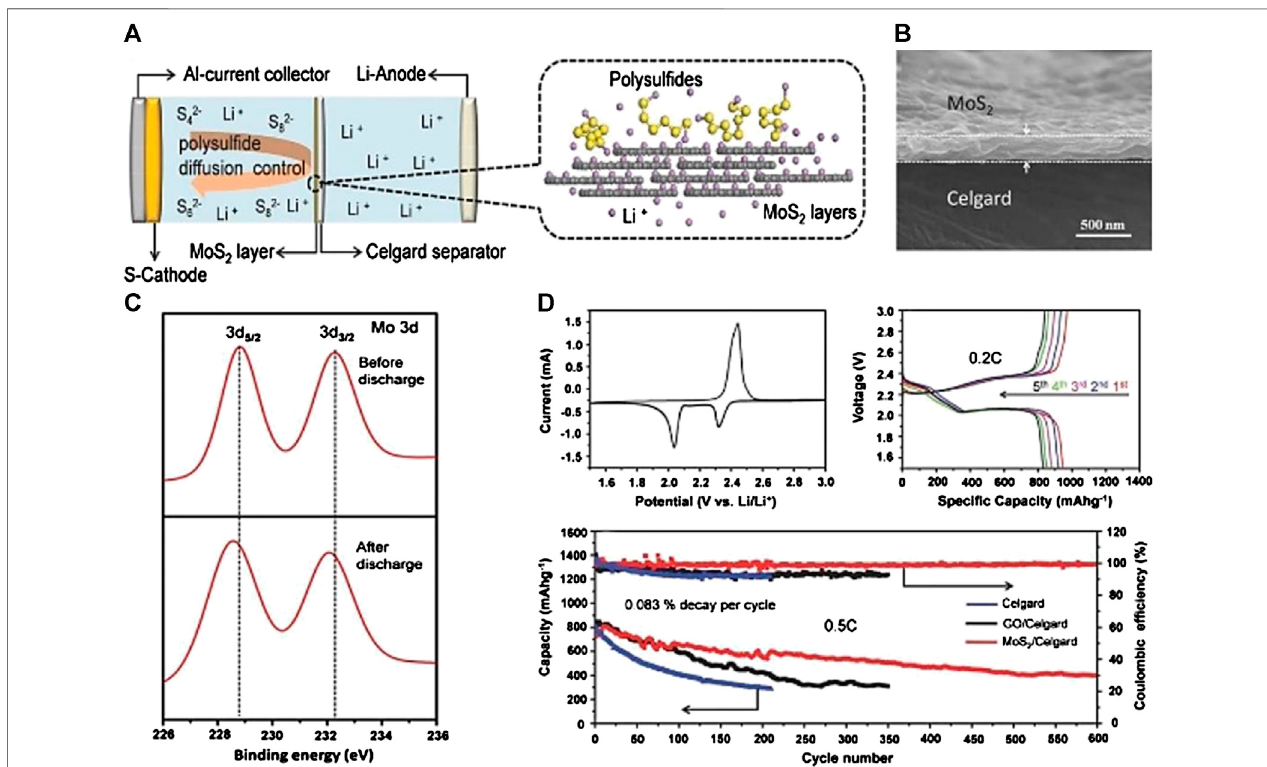
FIGURE4|(A) Schematiccellcon fi gurationand (B) crosssectionoftheMoS 2 /CelgardseparatorinLSBs (C) X-rayphotoelectronspectroscopyof3 dayspeaksof Mo before/after charge-discharge (D) Cyclic voltammetry pro fi le and Galvanostatic charge – discharge pro fi les of the cells with MoS 2 /Celgard separator, and Long life cycle test for various separators in LSBs. Reproduced with permission from (Ghazi et al., 2017).